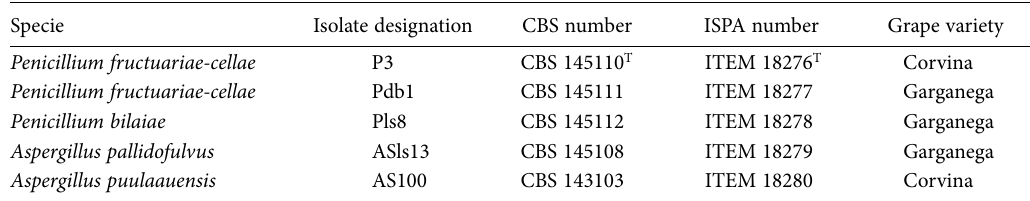
Table 1. Fungus isolates recovered from withered grape berries in this study.